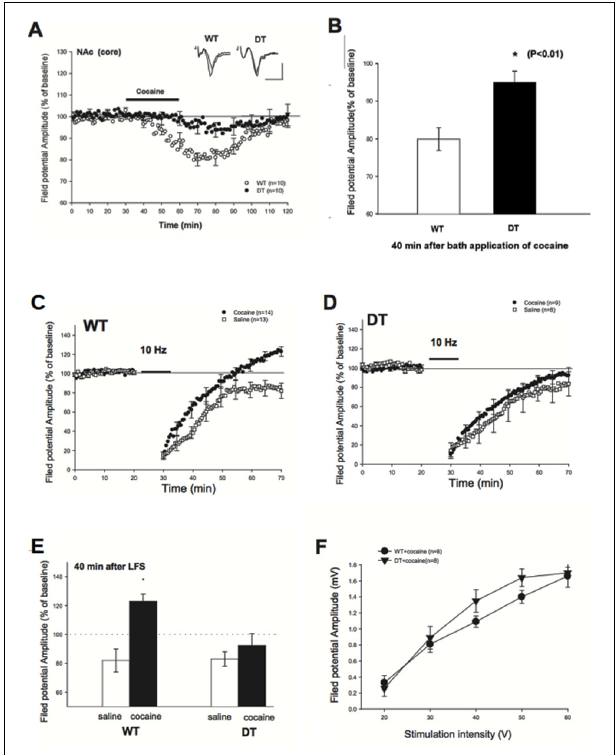
FIGURE 4 | Reduced depression of field potential at baseline and Long-Term Synaptic Depression (LTD) blockade impairment in cocaine-treated DN-CPEB mice. (A) Brain slices from WT and DN-CPEB were used to record the extracellular field potential from the core of NAc in the presence or not of cocaine (30 µ M), directly applied to the bath perfusion. (B) Quantification of the field potential amplitude at 40 min after cocaine application. DN-CPEB mice have a significantly different response compared to WT ( p < 0.01). WT (C,D) DN CPEB mice (DT = double transgenic) slices were used to assess LTD in the excitatory synaptic transmission of NAc elicited by low frequency (10 Hz) stimulation. (E) Graphical representation of the quantification of the responses recorded in (C,D) . (F) Input/output curve of WT and DN-CPEB mice following cocaine administration as a function of increased stimulation intensity. * p <